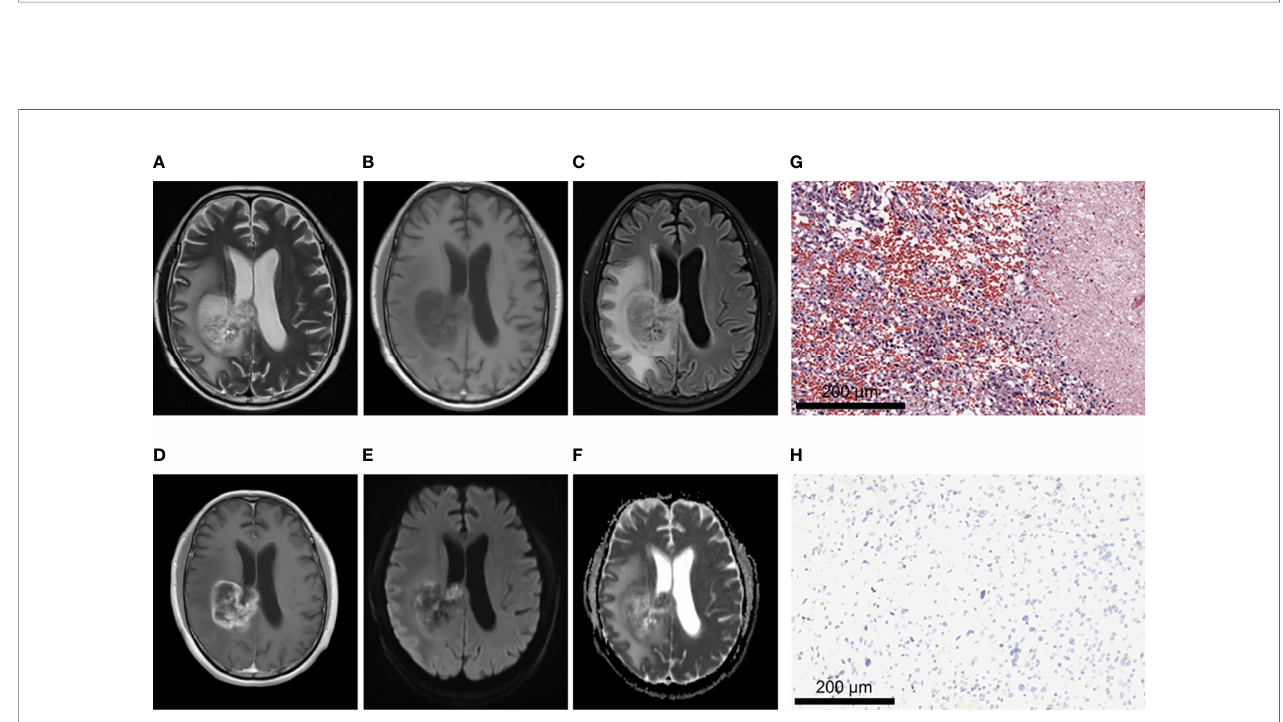
FIGURE 4 | A 43-year-old female patient with left frontal anaplastic astrocytoma, WHO grade III, IDH-mutant type. (A – C) MRI axial T2W, T1W, T2-FLAIR sequences showed clear tumor boundary, slightly uneven internal signal and no peritumor edema. (D) T1 postcontrast showed no obvious enhancement. (E, F) When b value is 1000, tumor was locally and slightly restricted diffusion in DWI and ADC images. (G) HE staining showed moderate to severe increase in cell density, accompanied by nuclear atypia and mitotic images (×200). (H) IDH1 positive expression